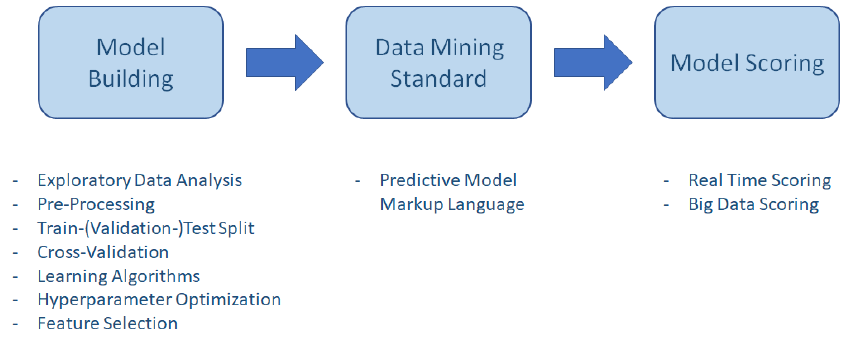
Figure 7. Predictive model markup language-based data-mining activity. The three main sections show the main stages in the development of the